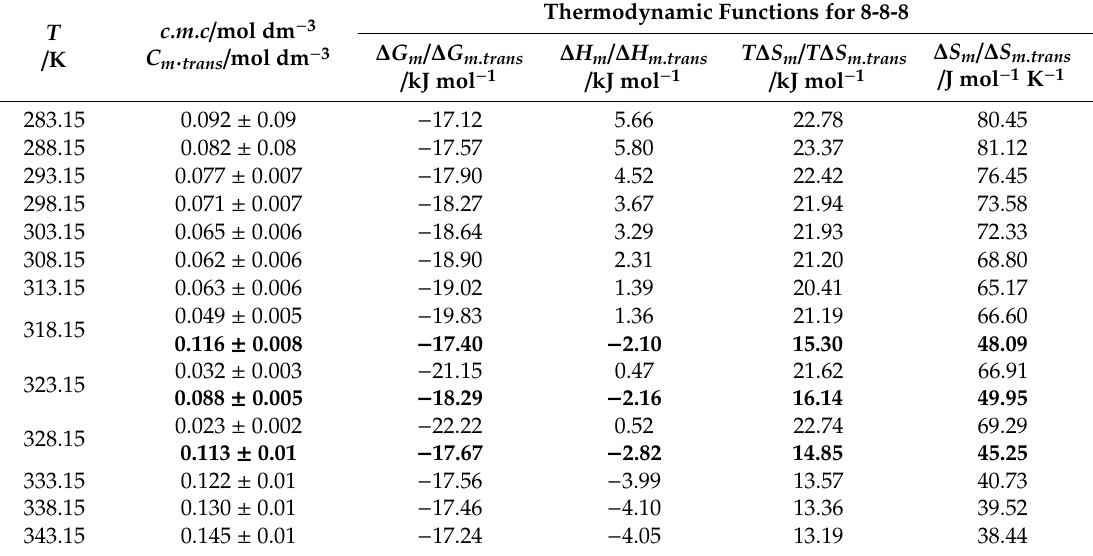
Table 2. Temperature dependence of micellisation parameters: critical micelle concentration (c.m.c), C m.trans and thermodynamic quantities of the micellisation and transformation process for aqueous surfactant solution 8-8-8 determined on the basis of calorimetric titration. The values for the micelle transformation process are shown in